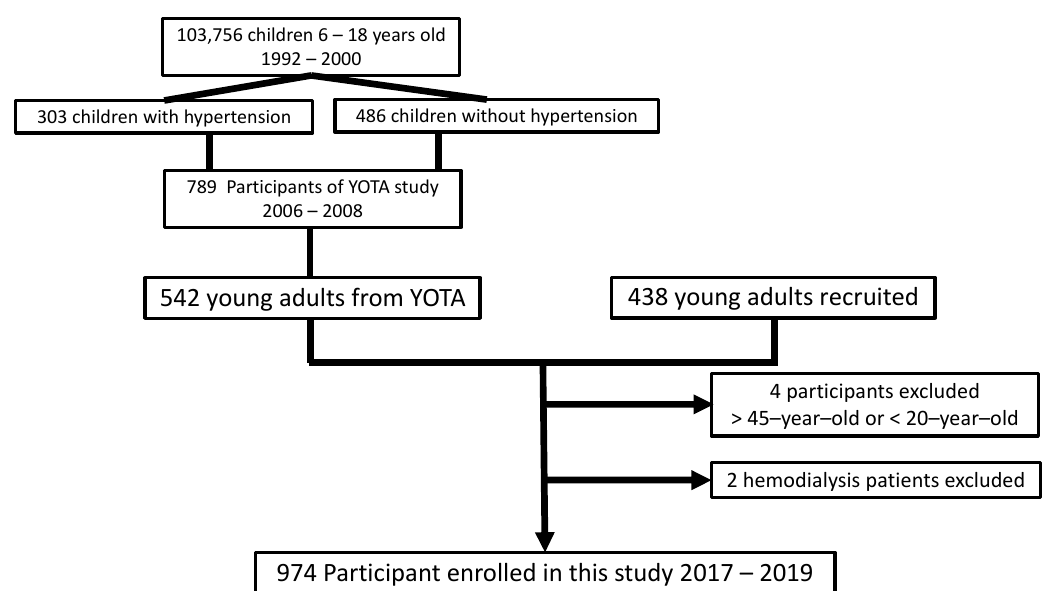
Figure 1. Recruitment flow chart for the New YOTA study.